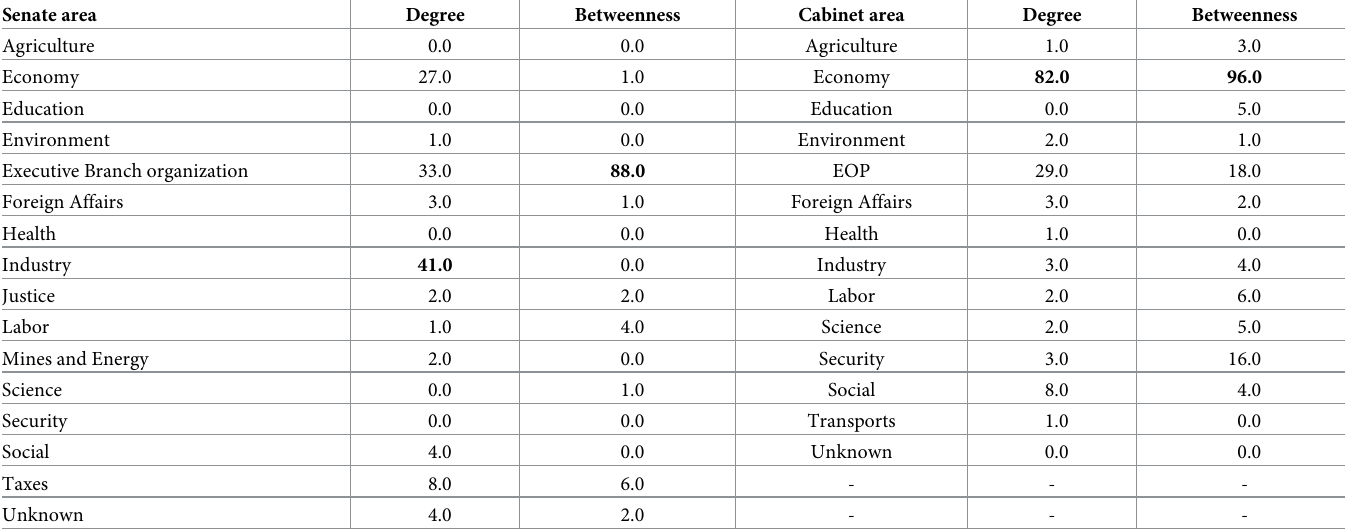
Table 9. Taxonomies’ 100 most central nodes.